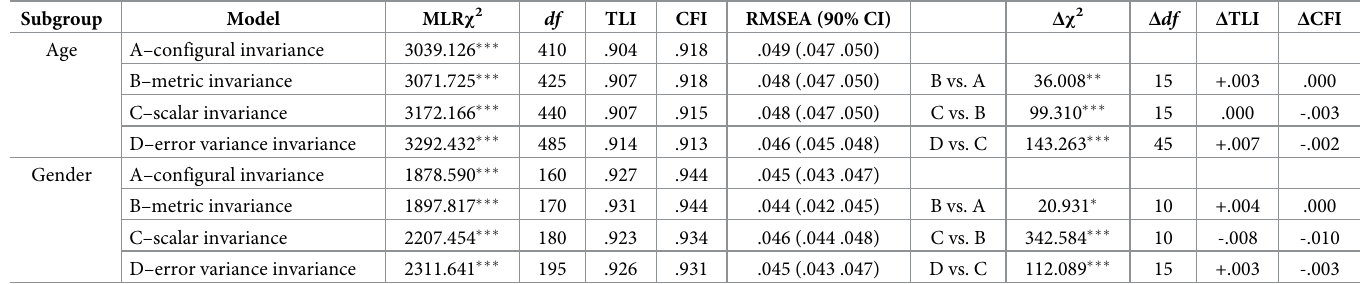
Table 3. Goodness-of-fit indices and model comparisons for CBF-PI-15 measurement invariance models.